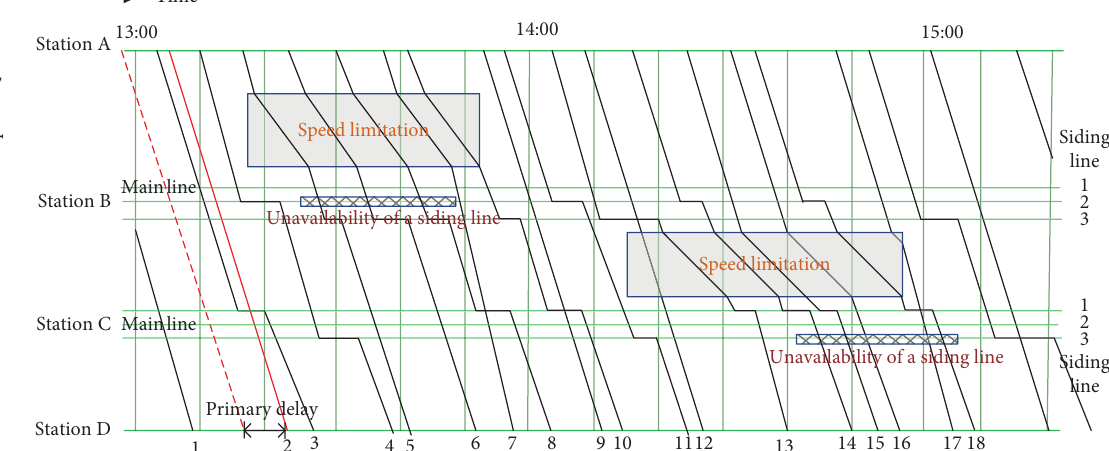
Figure 1: Illustration for